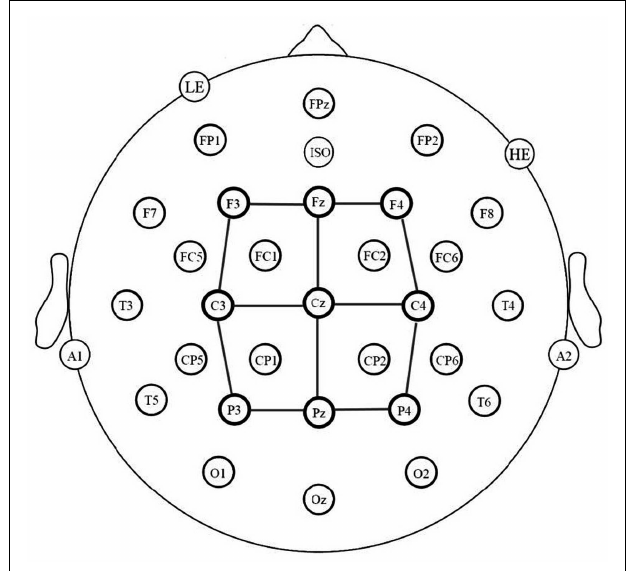
FIGURE 2 | Electrode montage and electrode sites used in the statistical analyses (connected by